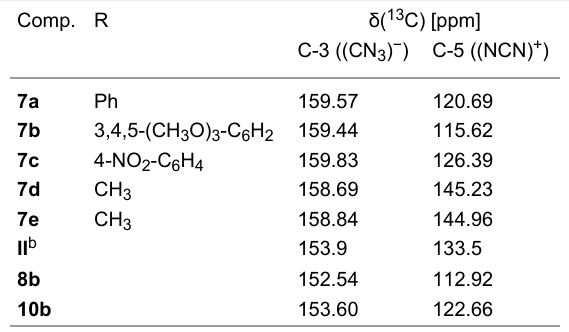
Table 3: 13 C chemical shifts of C-3 and C-5 (triazole ring) of mesoionic compounds 7a–e and II , triazolium salt 8b and triazole 10b a . Comp. R